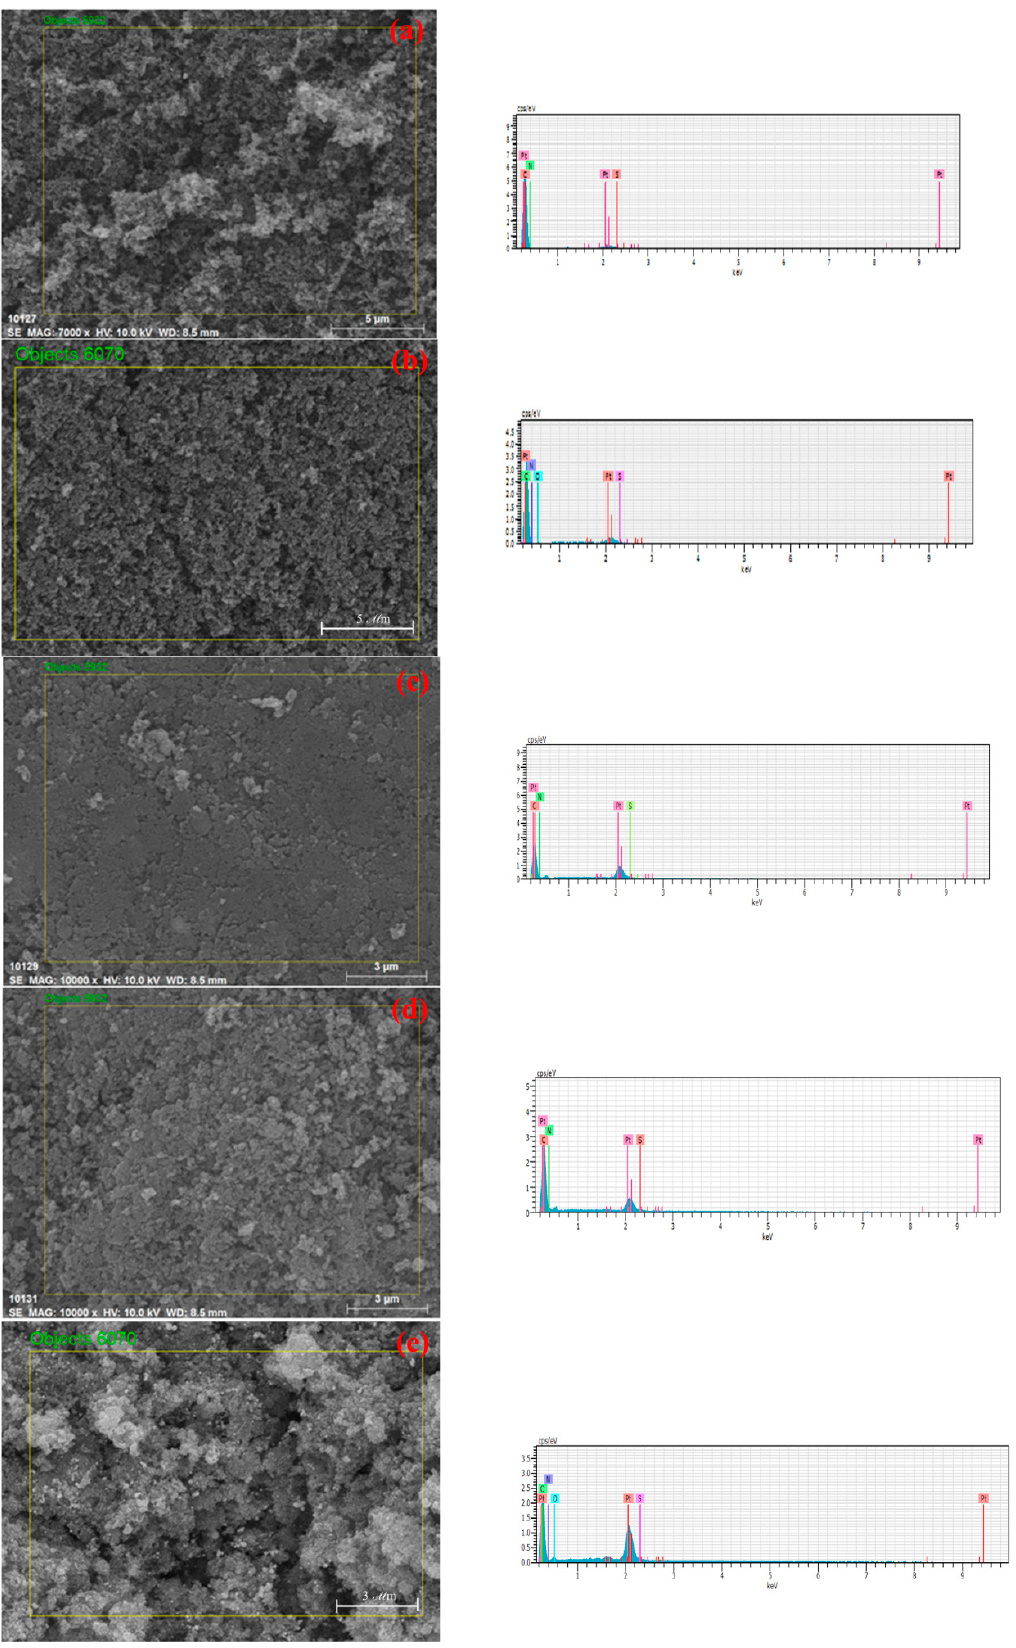
Figure 6. SEM micrographs and EDS of ( a ) Pt/XC72/500, ( b ) Pt/XC72/800, ( c ) Pt/EB-XC72/500, ( d ) Pt/EB-XC72/800, and ( e ) Pt/EB-XC72/900.